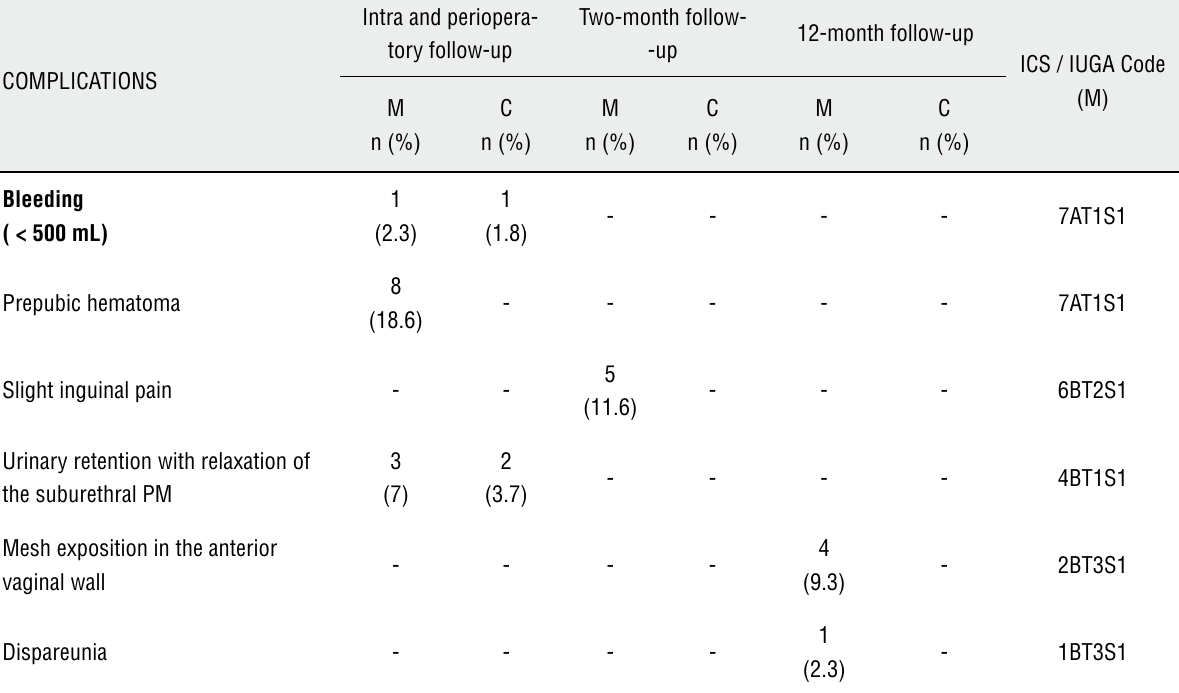
Table 6 - Safety according to the reported complication rates and to the standardized codes of the International Continence Society and International urogynecology Association at intra, peri and postoperatory periods after 12-month follow-up of Mesh (M) (n = 43) and Control (C) (n = 54)